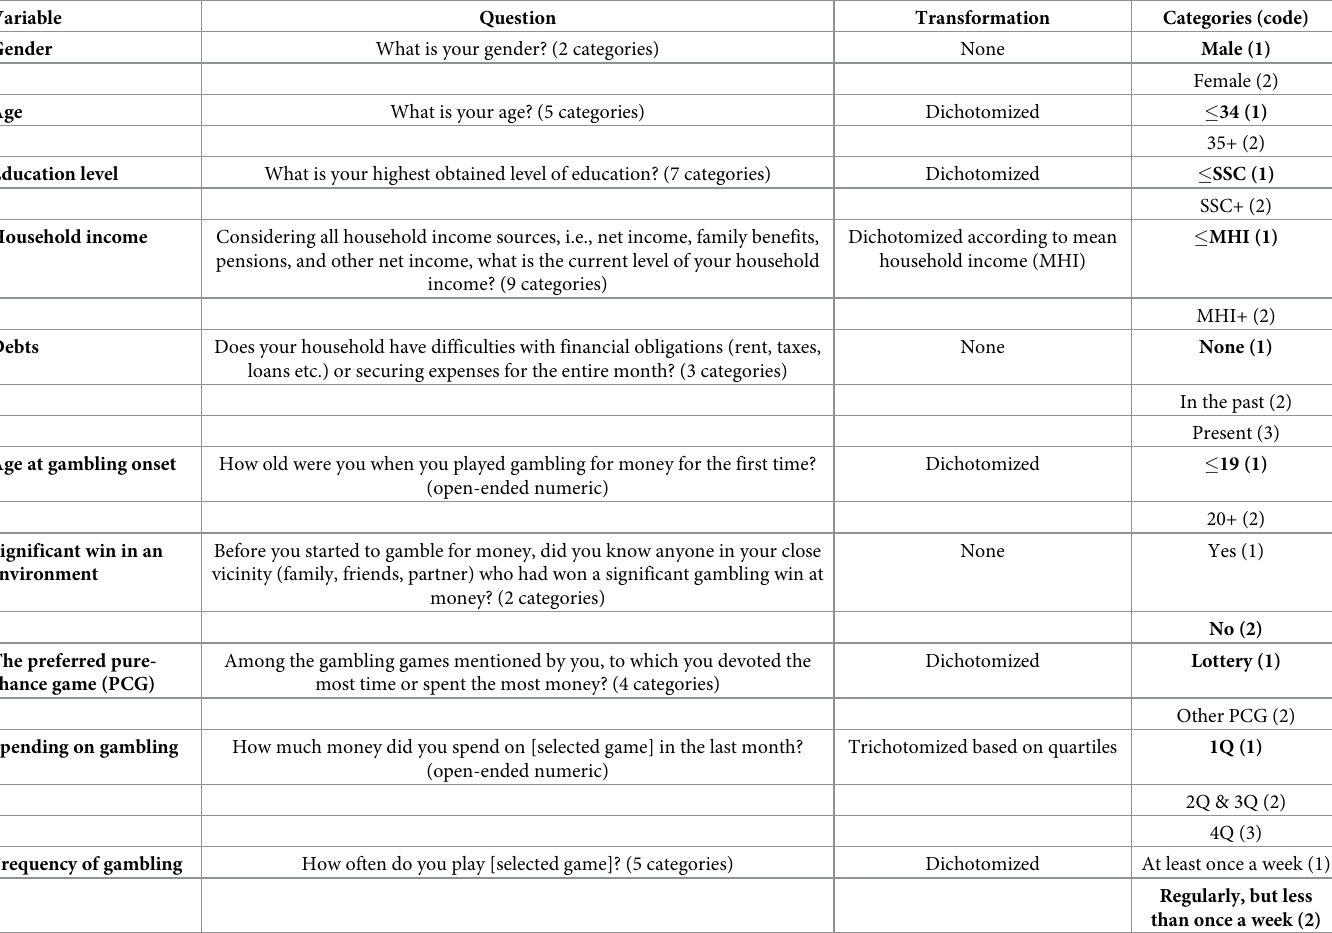
Table 2. Sociodemographic and gambling-related variables used in the study–their measurement and